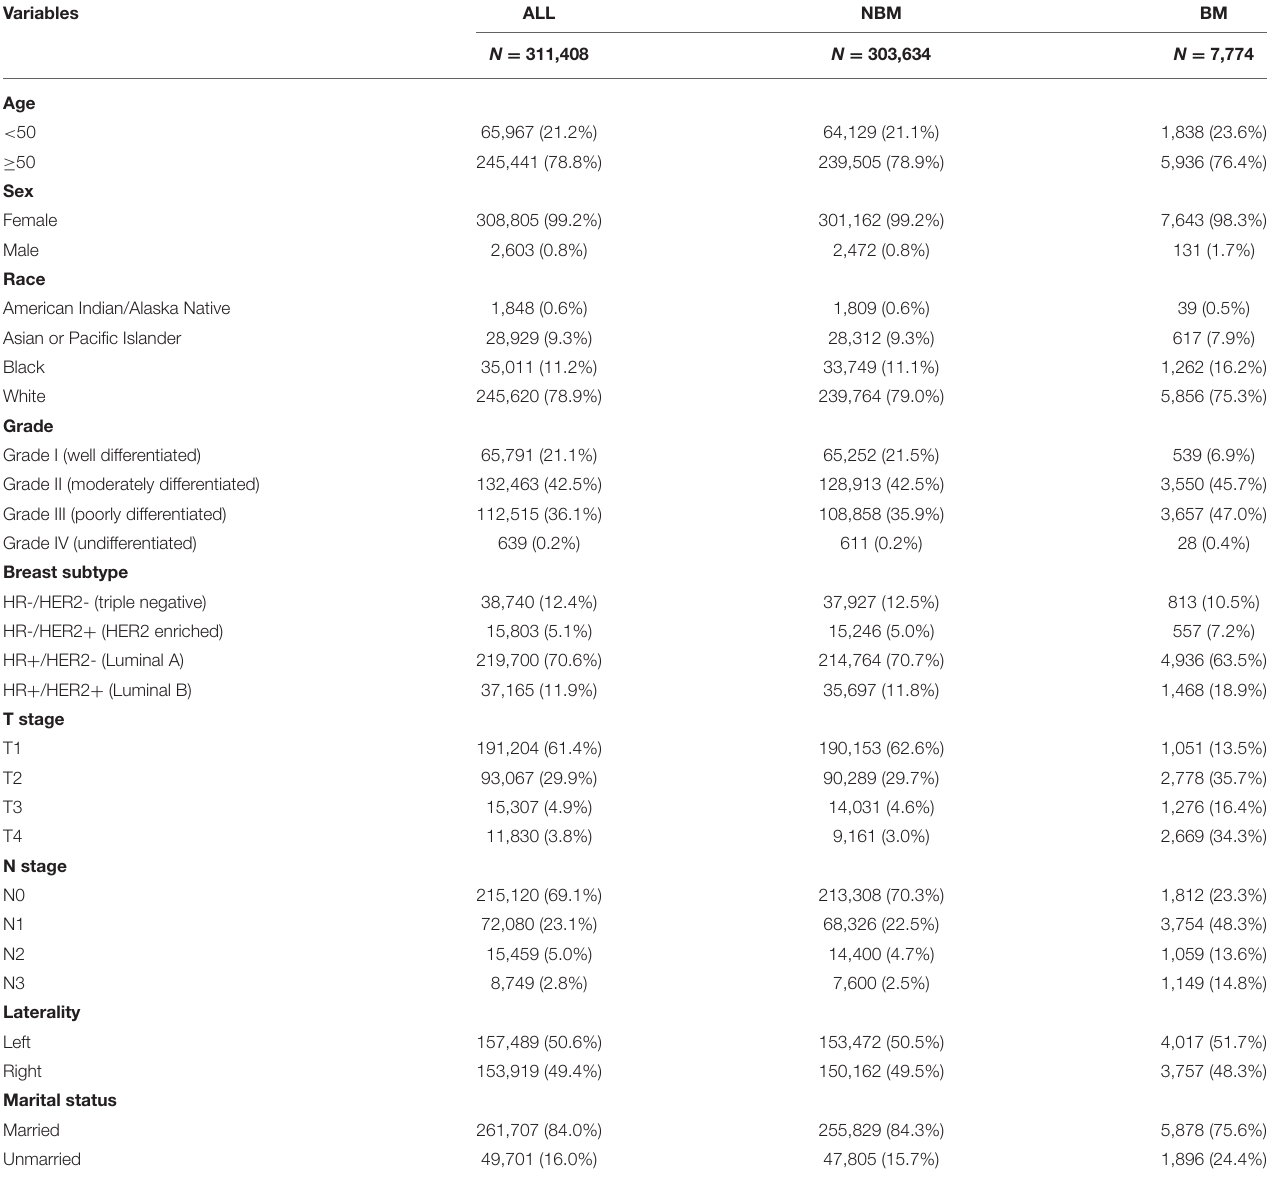
TABLE 1 | Clinical and pathological characteristics of study